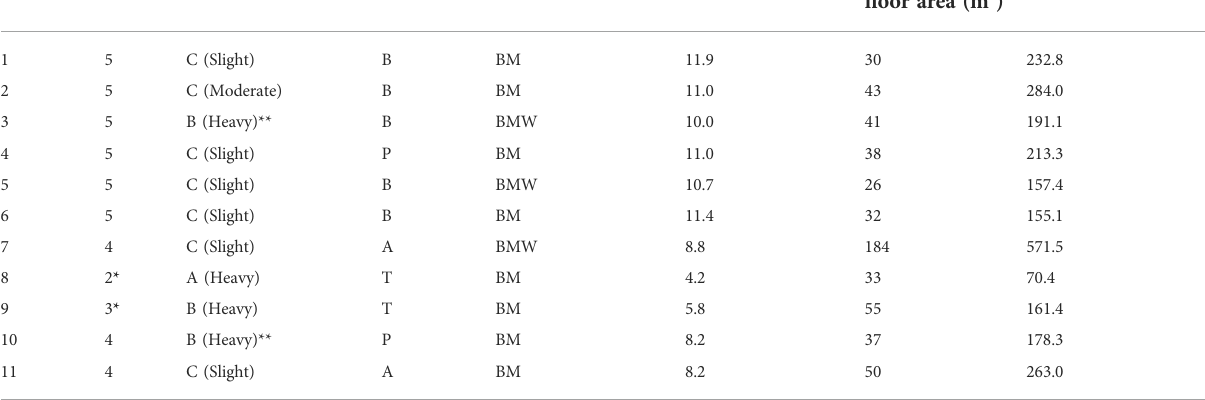
TABLE 3 Measured building